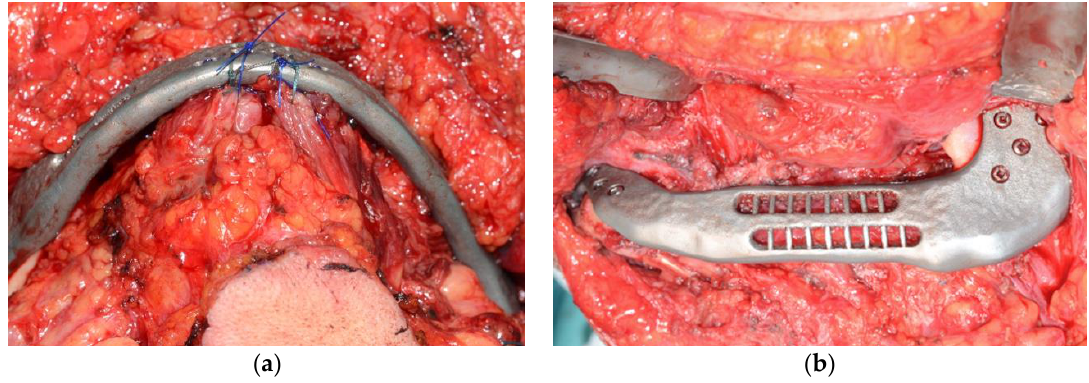
Figure 4. Intraoperative images of customised bridging mandibular prosthesis (CBMP) positioning. ( a ) CBMP for a lateral defect. ( b ) Suprahyoid muscle anchorage to the CBMP in an anterior defect .